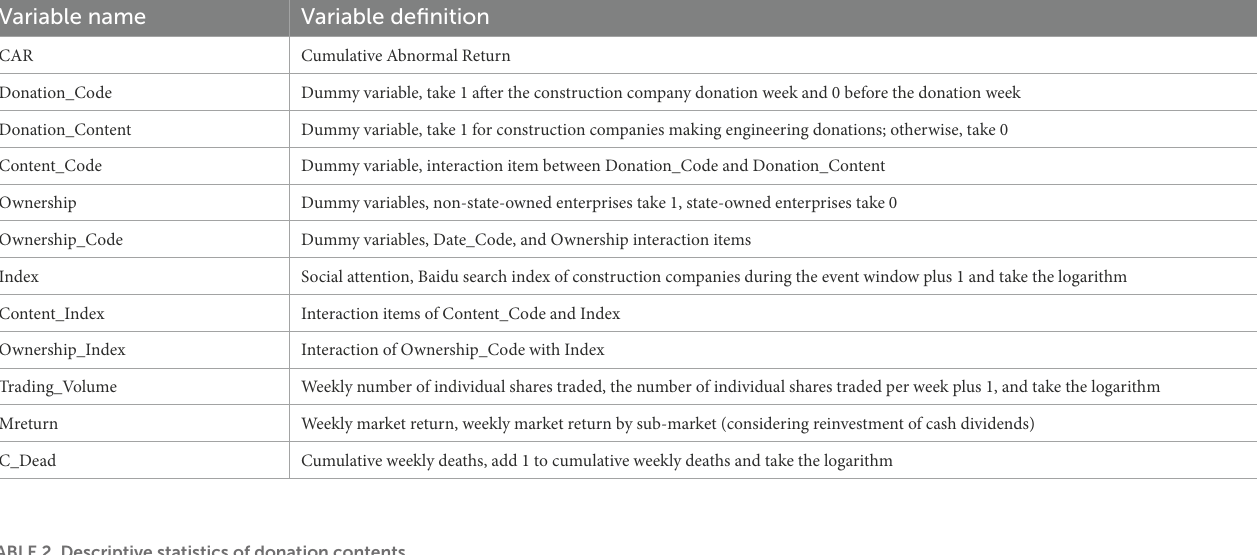
TABLE 2 Descriptive statistics of donation contents.